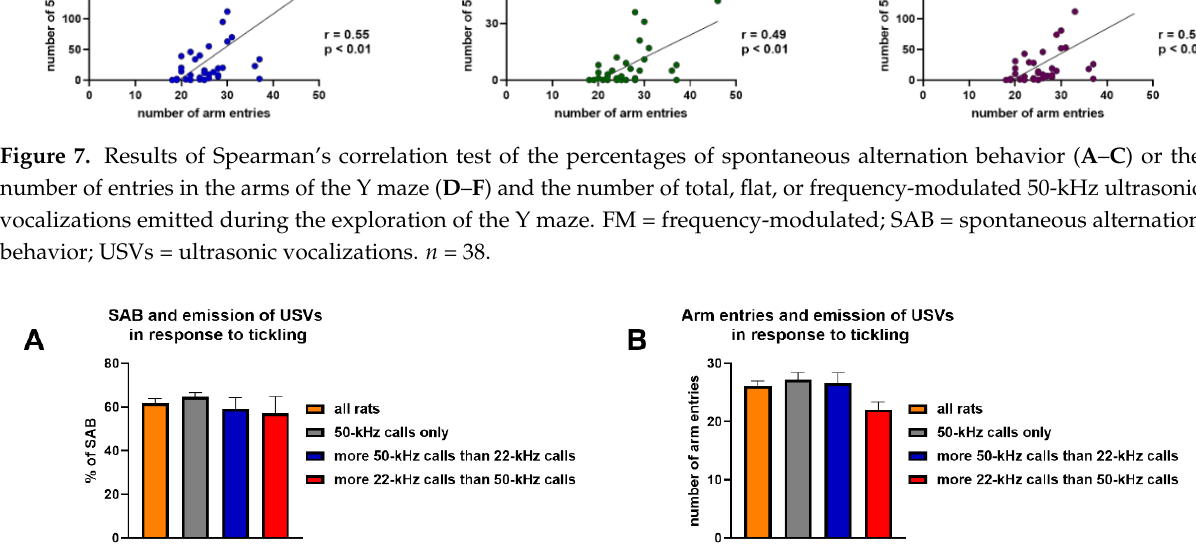
Figure 9. Results of Spearman’s correlation test between the percentages of spontaneous alternation behavior and the numbers of total 50-kHz ultrasonic vocalizations ( A ), flat 50-kHz ultrasonic vocal- izations ( B ), frequency modulated 50-kHz ultrasonic vocalizations ( C ) or 22-kHz ultrasonic vocali- zations ( D ) emitted in response to tickling. FM = frequency modulated; SAB = spontaneous alterna- tion behavior; USVs = ultrasonic vocalizations. n = 40. Conversely, Spearman’s test revealed that the number of entries in the arms of the Y maze were significantly correlated with the number of FM 50-kHz USVs (r = 0.32, p < 0.05)